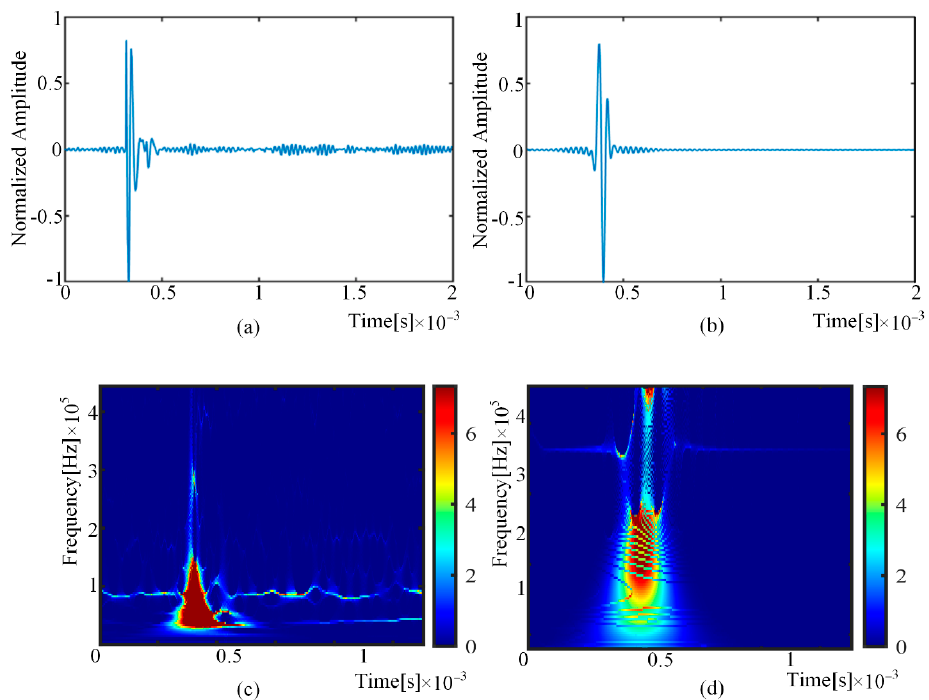
Figure 8. Comparison between the experimental result and the analytical modeling prediction result: ( a ) the waveform of experimental detection; ( b ) the waveform of analytical prediction; ( c ) experimental results (synchronous compression wavelet transform); ( d ) analytical prediction results (synchronous compression wavelet transform).